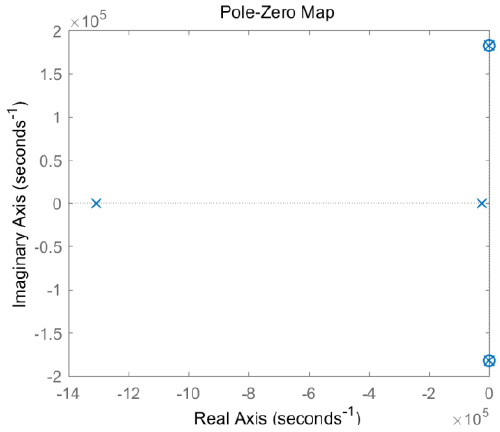
Figure 11. Zero-pole diagram of symmetrical circuit model 2.